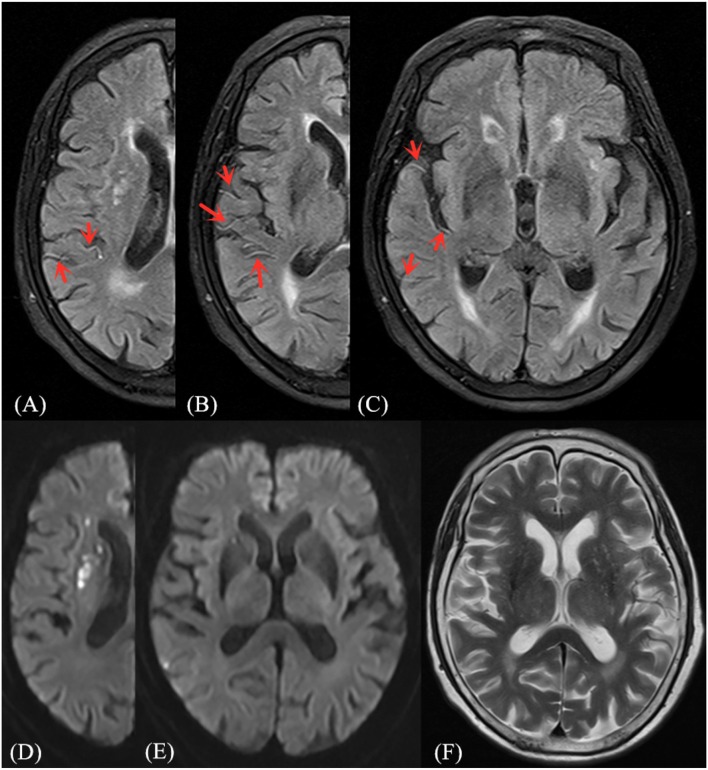
Illustrative case of FVH-DWI mismatch. Magnetic resonance (MR) imaging of a 71-year-old man obtained 1 day after sudden onset of left hemiparesis. Prominent FVH on FLAIR (A–C) with small hyperintense lesions in the right MCA territory on admission DWI (D,E), which is more extensive beyond the boundaries of the DWI high signal area, indicating an FVH-DWI mismatch. Prominent FVH presents flow voids on the corresponding T2WI image (F).